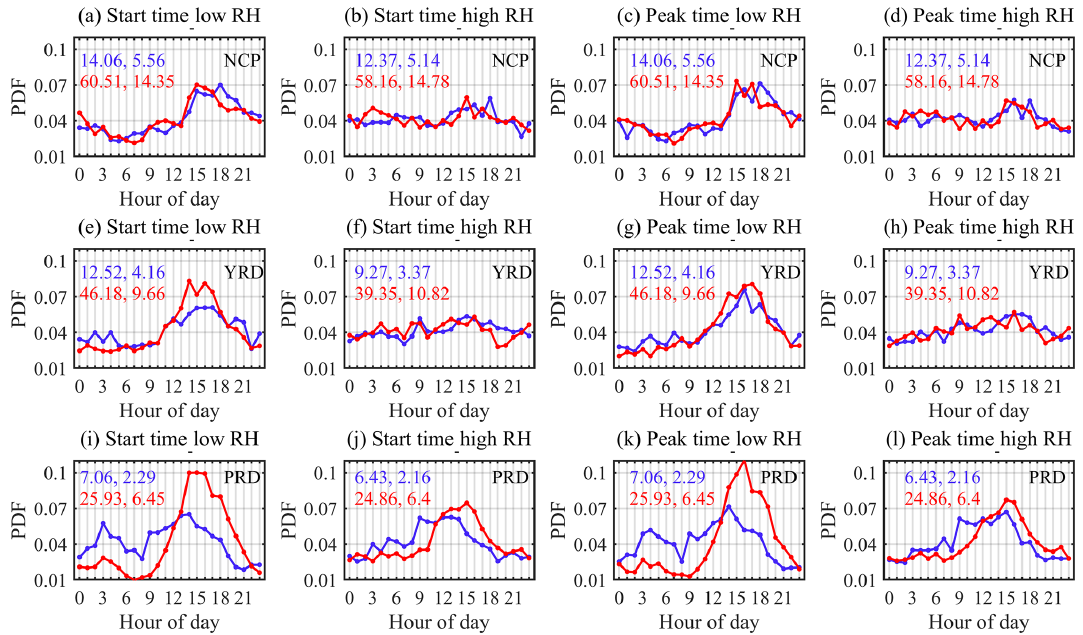
Figure 10. Normalised PDFs of precipitation start time under (a, e, i) low-humidity conditions and (b, f, j) high-humidity conditions and the precipitation peak time under (c, g, k) low-humidity conditions and (d, h, l) high-humidity conditions in June–August from 2015 to 2020 over the NCP, YRD, and PRD, respectively. The blue (red) numbers are the average (the first column) and standard deviation (the second